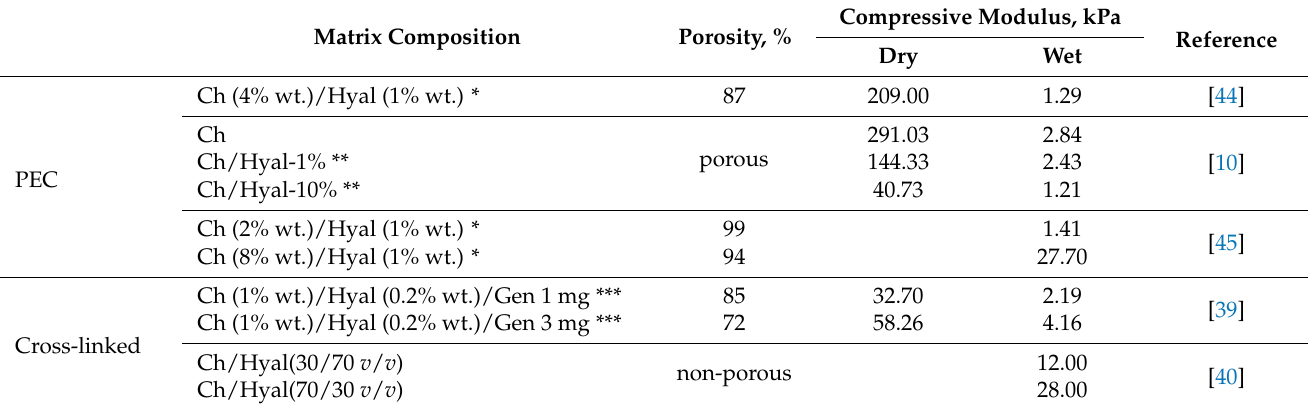
Table 2. Mechanical properties of hydrogel matrices based on chitosan and chitosan/hyaluronic acid. Matrix Composition Porosity, %